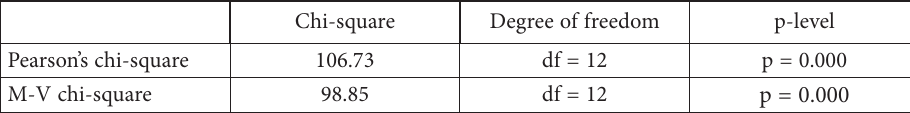
Table 5. χ 2 test for motivational factor base salary from the point of view of education Chi-square Degree of freedom p-level Pearson’s chi-square